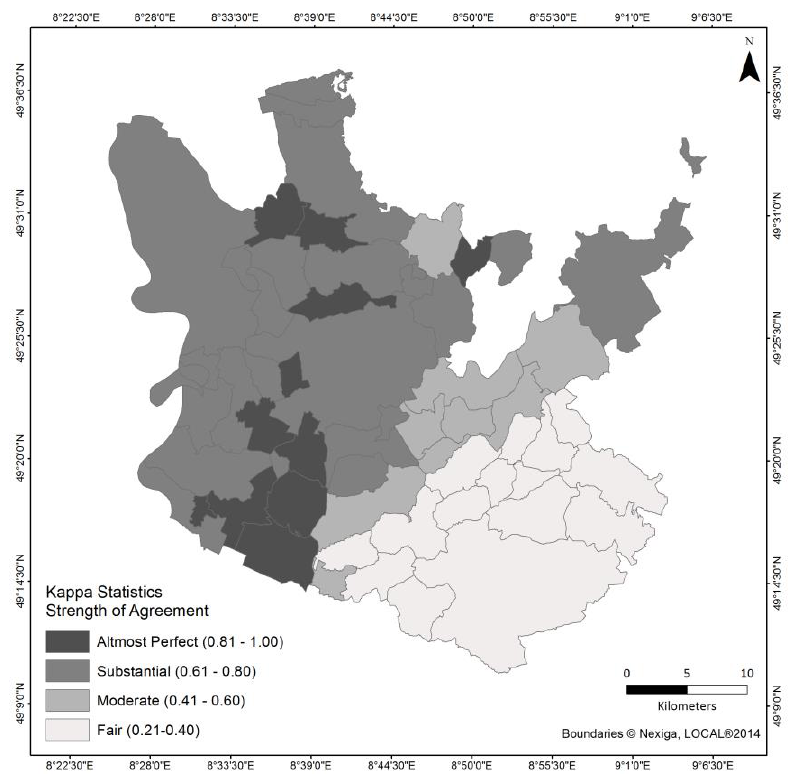
Figure 4. Cohen’s kappa for the municipalities in the study area classified according to Landis and Koch